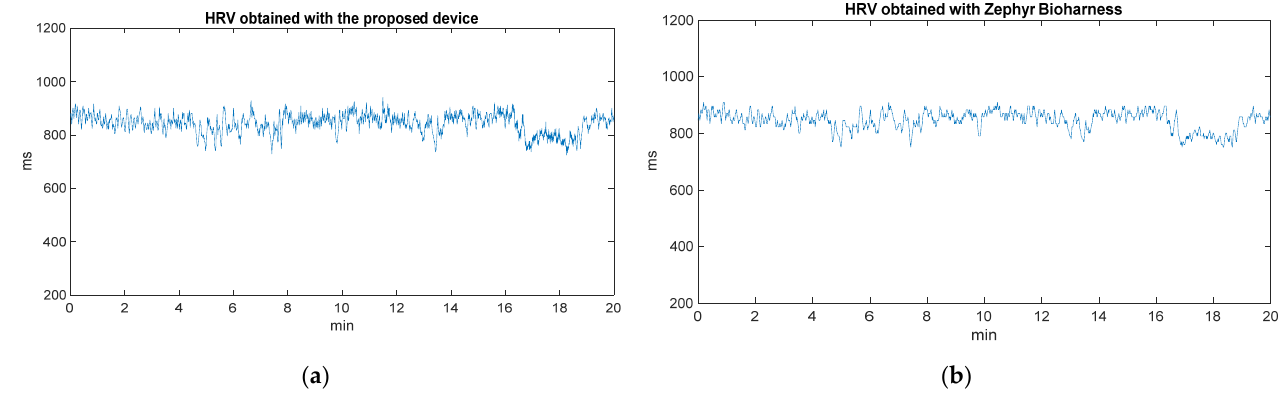
an MAPE of <10% was deemed reliable.